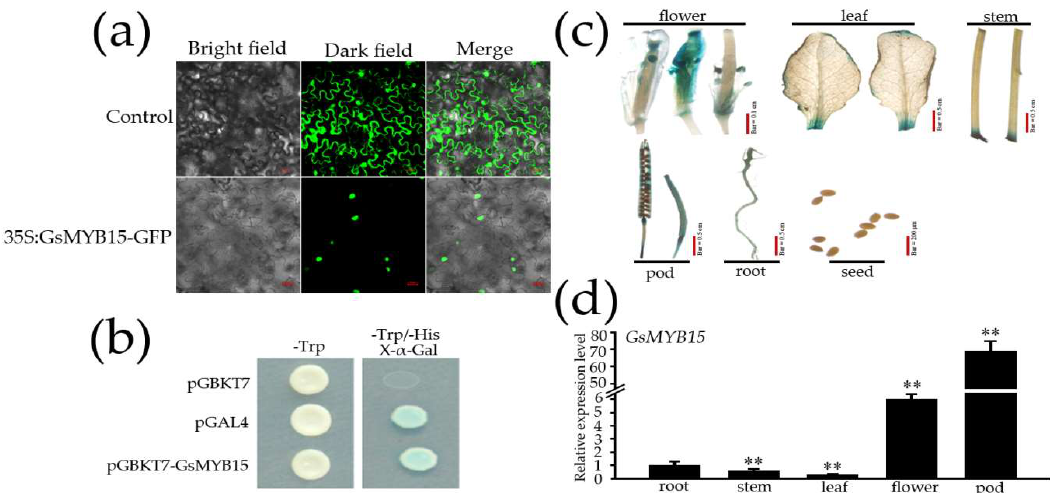
Figure 2. Sub-cellular localization, transcriptional activation, GUS staining and tissue-specific expression of GsMYB15 . ( a ) Control, transient expression of the PJL12m-GFP vector in tobacco